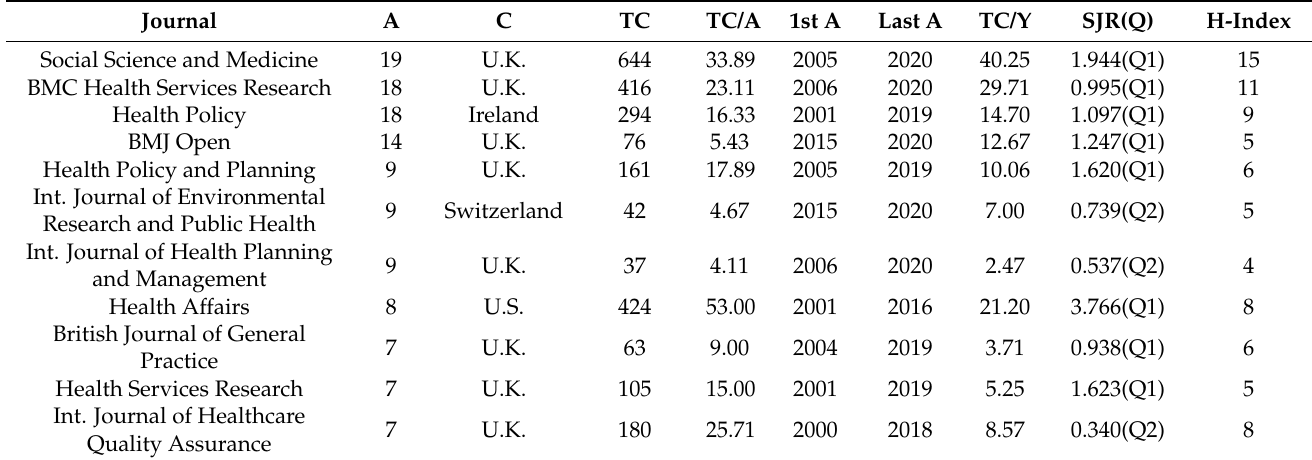
Table 2. The top 11 most productive journals on PS and HP from